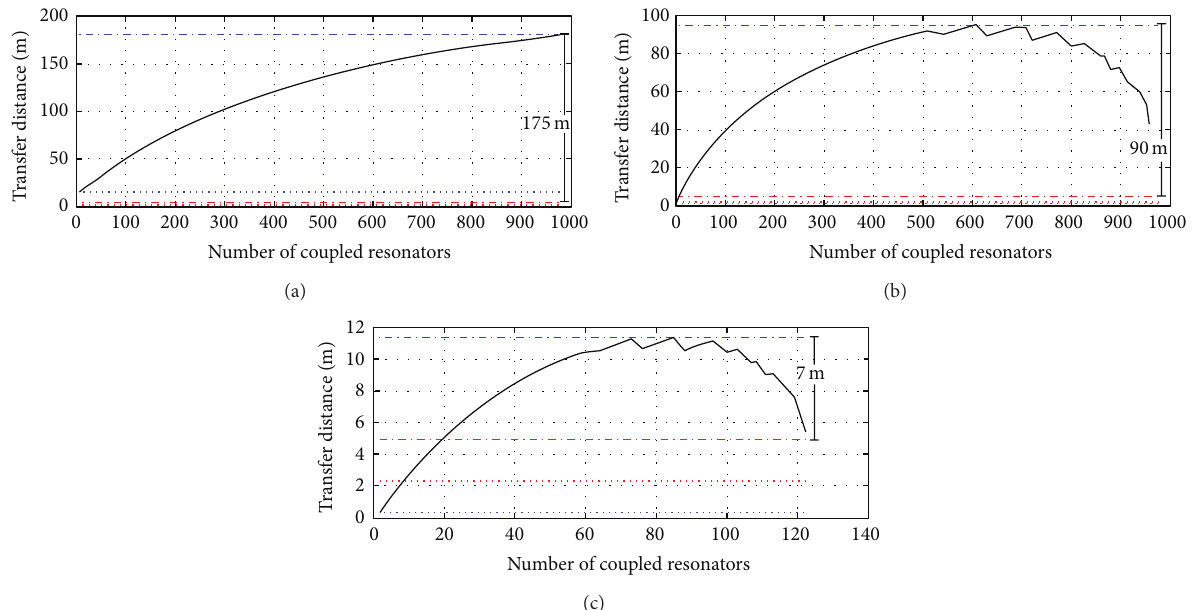
Figure 13: Transfer distance versus the number of coupled resonators when DCR configuration scenario A properties (—) are applied for various TRs as well as the minimum ( ⋅⋅⋅ ) and maximum (- ⋅ - ⋅ ) dimensions of HV/MV power transformers. (a) Minimum HV/MV power transformer TR. (b) Median HV/MV power transformer TR. (c) Maximum HV/MV power transformer TR.